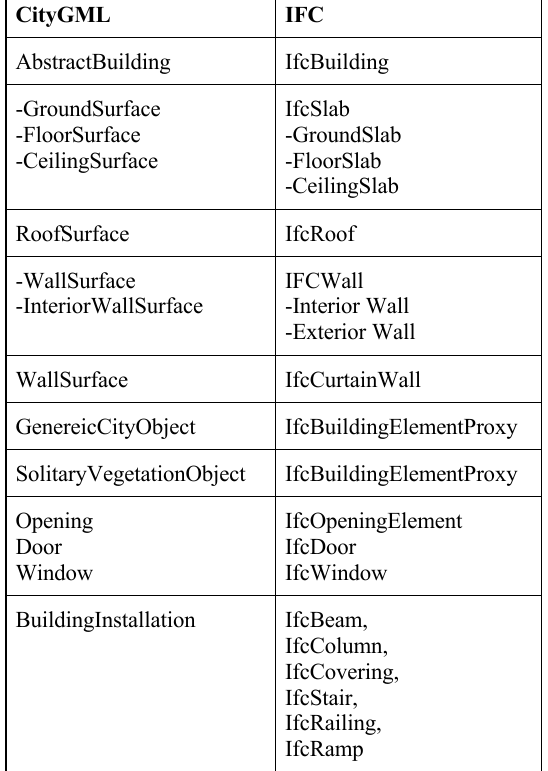
Table 1. IFC-CityGML Mapping (Kumar & Saran, 2015), own work